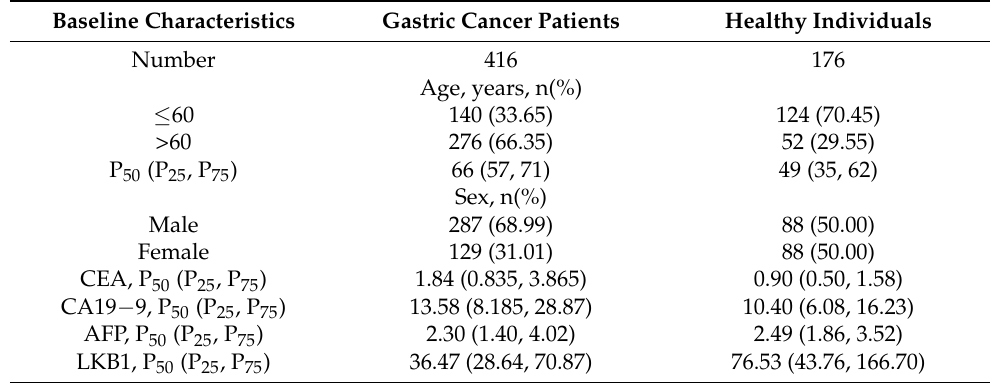
Table 1. Comparison between GC patients and healthy individuals with clinical parameters. Baseline